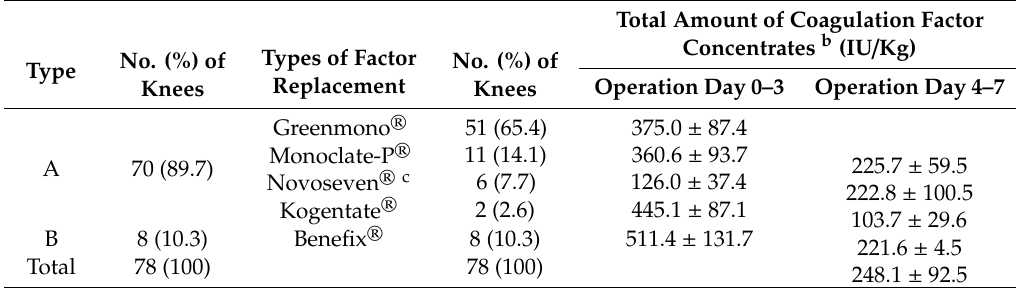
Table 3. Types of perioperative factor replacement and dosage a